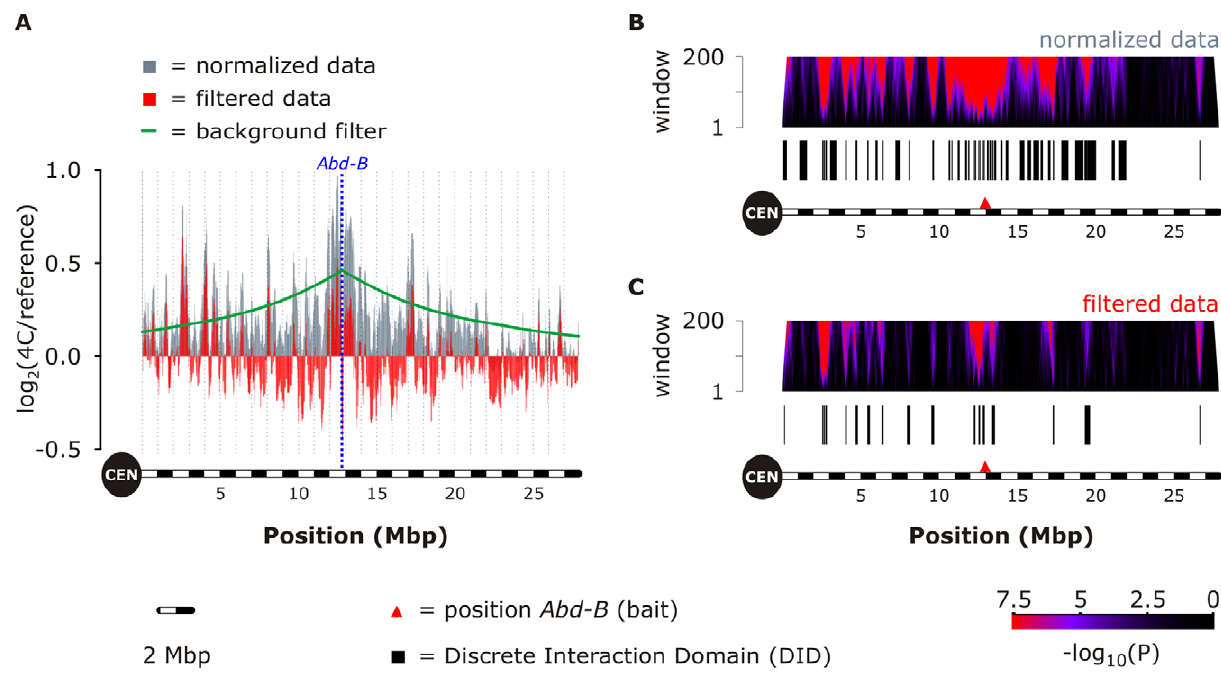
Figure 1. Detection and visualization of long-range chromatin interactions. (A) Genomic clusters of multiple restriction fragments with increased 4C signals were identified using a sliding window filter on the normalized data (running median, window = 51 probes; grey bars) along chromosome 3R. We applied a ‘‘background filter’’ to correct for interactions that are a consequence of short nucleotide distance to the bait sequence (green curve). After filtering the normalized data, clusters of restriction fragments that exceed the curve (running median, window = 51 probes; red bars) represent long-range chromatin interactions. X-axis indicates the chromosomal position (in Mbp), while log 2 -transformed 4C signals are shown on the y-axes. Position of Abd-B is blue dashed line.(B) Domainograms visualize long-range chromatin contacts detected using normalized data obtained with the Abd-B promoter as bait (red arrowhead). X-axis indicates the chromosomal position (in Mbp), while the window size of the domainogram algorithm is shown on the y-axis. Interactions are plotted using a color scale with black for non-significant and red for highly significant (scale bar). Only window size # 200 probes (corresponding to 840 Kbp on average) are shown. We used a dynamic programming algorithm to identify non-overlapping Discrete Interaction Domains (DIDs, black rectangles bottom). (C) Domainogram of Abd-B data after applying the ‘‘background filter.’’ Plotted as in B. Note, centromeric sequences (CEN) are not drawn to scale.